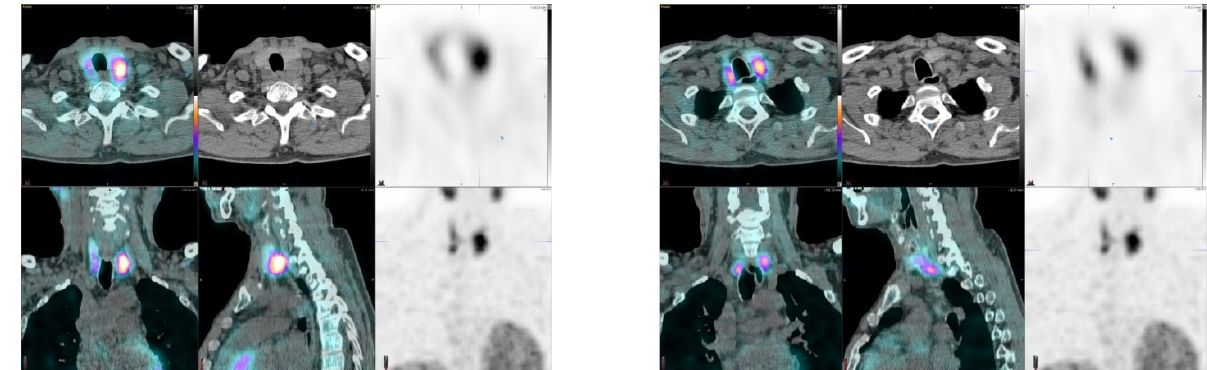
Figure 2. A 55-year-old male with hyperparathyroidism, right inferior adenoma, left parathyroid carcinoma. His S-PTH concentration was 478 ng/L and S-Ca 11.1 µ g/L. The SUVmax values of the right-sided adenoma were 6.3 (CGZAS) and 3.8 (CGAS), respectively. Visually, this uptake was weak (1 < TBR < 2) and lesion diameters on CT were 21 mm × 24 mm. The carcinoma on the left demonstrated higher SUVmax values than the adenoma: 8.3 (CGZAS) and 7.3 (CGAS), respectively. Visually this uptake was moderate (2 < TBR < 3) and the lesion diameters on CT were 25 mm × 30 mm. This patient was not operated because of MEN syndrome.